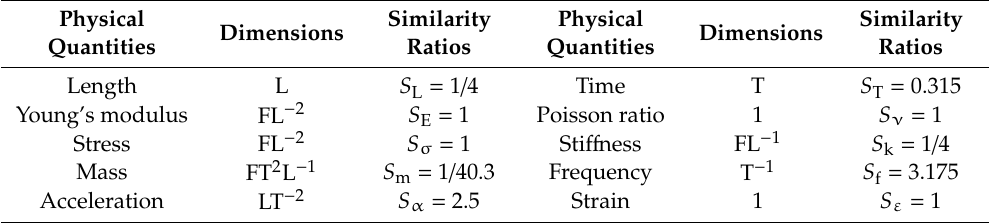
Table 1. Similitudes of the test model.